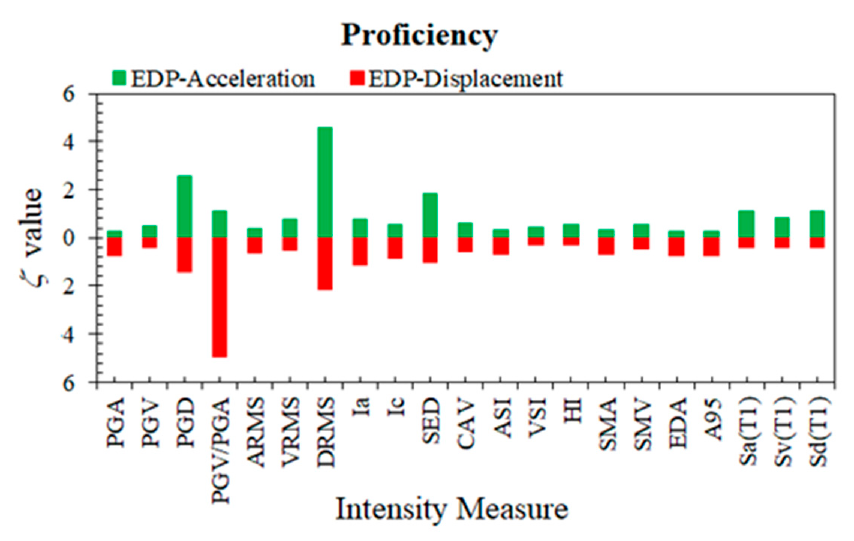
Figure 9. Proficiency comparison.